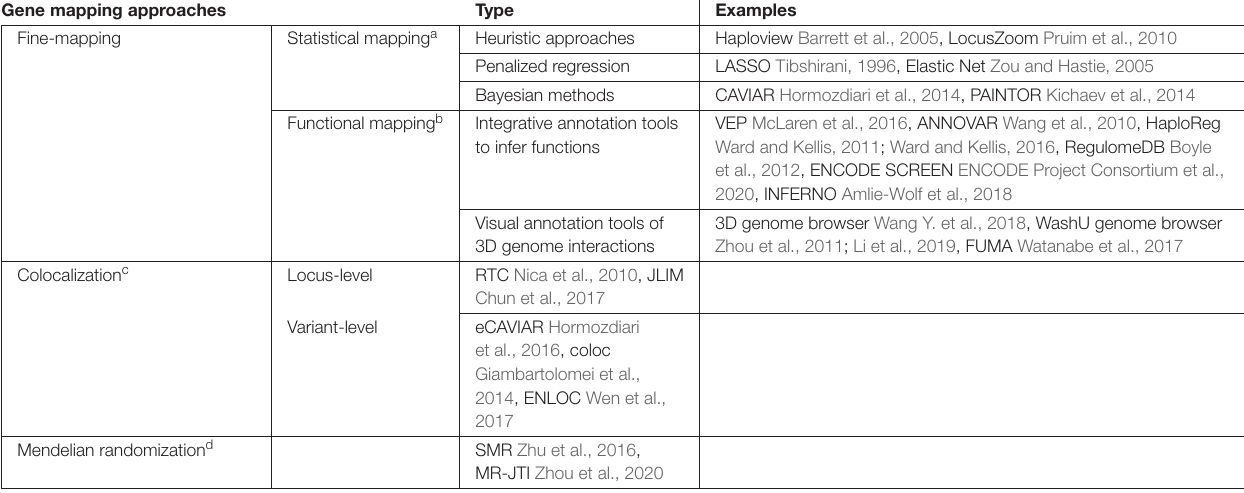
TABLE 1 | Toolbox of gene-mapping methods and gene-prioritization methods (see Table 2 for TWAS). Gene mapping